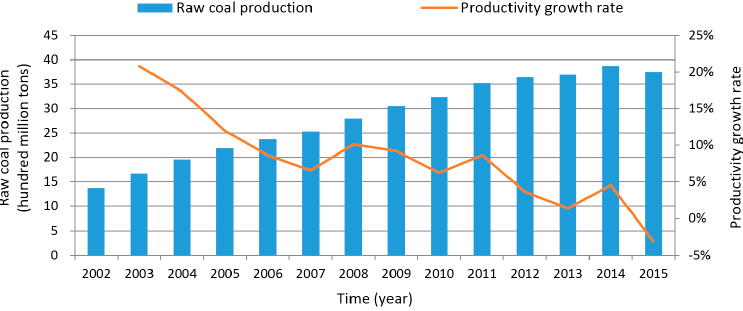
Figure 2. Historical data of raw coal production and productivity growth rate.